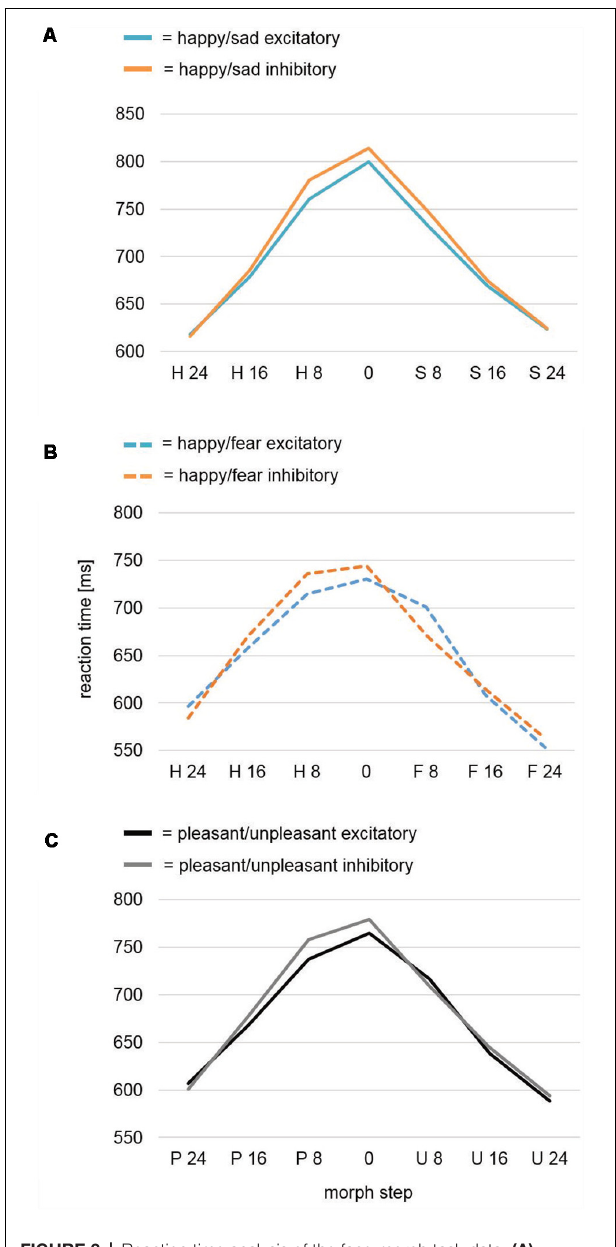
FIGURE 3 | Reaction time analysis of the face-morph task data. (A) Reaction time analysis for study Happy/Sad. After excitatory vmPFC-tDCS, participants were faster for highly ambiguous faces in comparison to after inhibitory vmPFC-tDCS as revealed by a significant quadratic contrast. No difference was found between categorization of happier and sadder face morphs. (B) Reaction time analysis for study Happy/Fear. In a previously assessed sample featuring happy-fearful face morphs (Winker et al., 2018), a cubic trend for analysis of all morph steps and a significant cubic contrast after exclusion of the outer (most distinct) morph steps occurred. In contrast to happy-sad face morphs, excitatory vmPFC-tDCS might have specifically decreased reaction times for happier, highly ambiguous face morphs, whereas inhibitory vmPFC-tDCS decreased reaction times for more fearful, highly ambiguous face morphs. (C) Conjoint reaction time analysis Pleasant/Unpleasant. An analysis across both studies (Happy/Sad, Happy/Fear) again featured a significant cubic contrast for Morph Step in the ( Continued